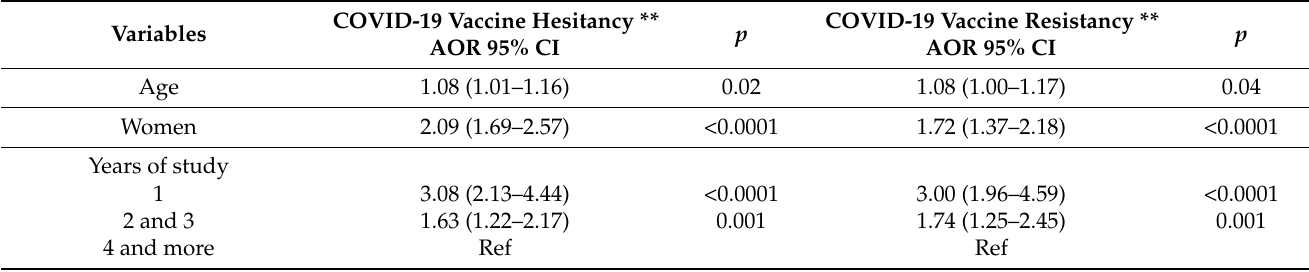
Figure 2. ( A ): Vaccine intention according the courses studied ( N = 3089). ( B ): Vaccine intention among the healthcare student ( N = 1999). Table 3. Factors associated with the COVID-19 vaccine decision (logistic regression